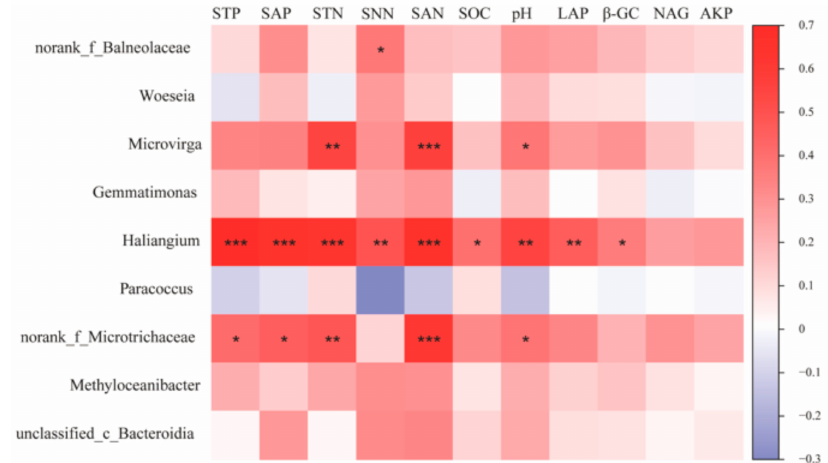
Figure 8. Correlation of bacterial keystone species in co-occurrence networks with environmental factors. Note: *, **, and *** in the figure indicate p < 0.05, p < 0.01, and p < 0.001, respectively; The values on the axis indicate R-value.